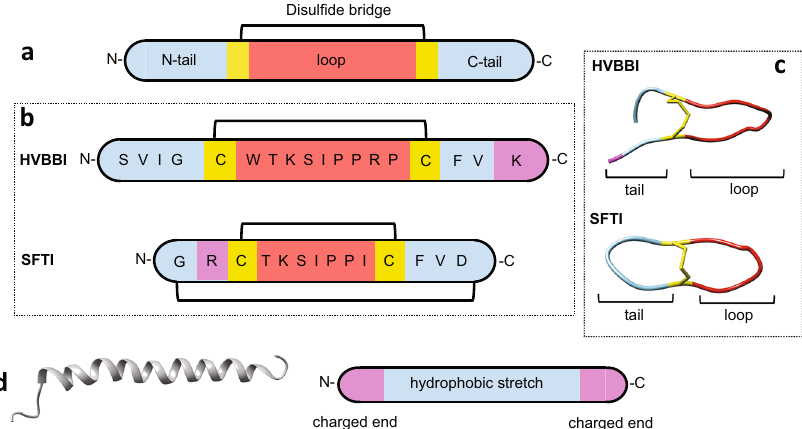
Fig. 1 Design of BBI-based antibacterial peptides. a A general schematic of Bowman – Birk Inhibitor structure. b The peptide exists in a hairpin loop conformation due to formation of disul fi de bridge between the loop- fl anking cysteines. c The structural elements of the peptides as observed in crystal structures. SFTI-PDB ID:1SFI, HVBBI-PDB ID:4U2W. d Schematic representation of a cationic peptide structure (Moricin- PDB ID:1KV4). Loop region is indicated by red, cysteines are colored yellow, tail region is colored blue, and cationic residues in the tail region are colored